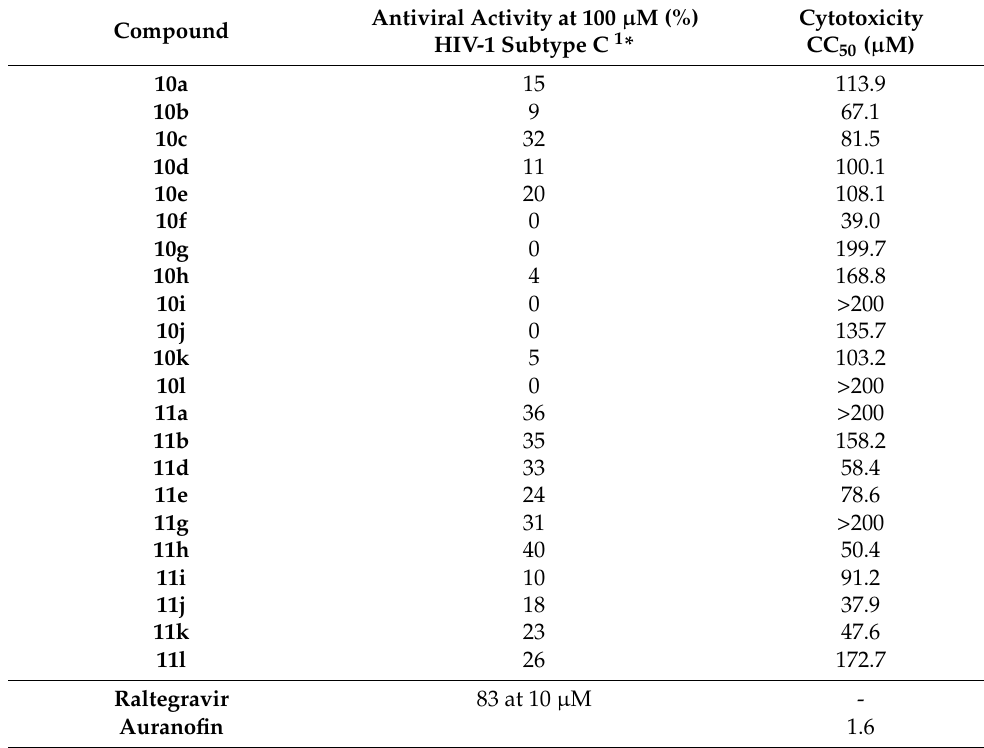
Table 4. The HIV-1 IN-LEDGF/p75 cell-based assay results for 1,5-diaryl-1 H